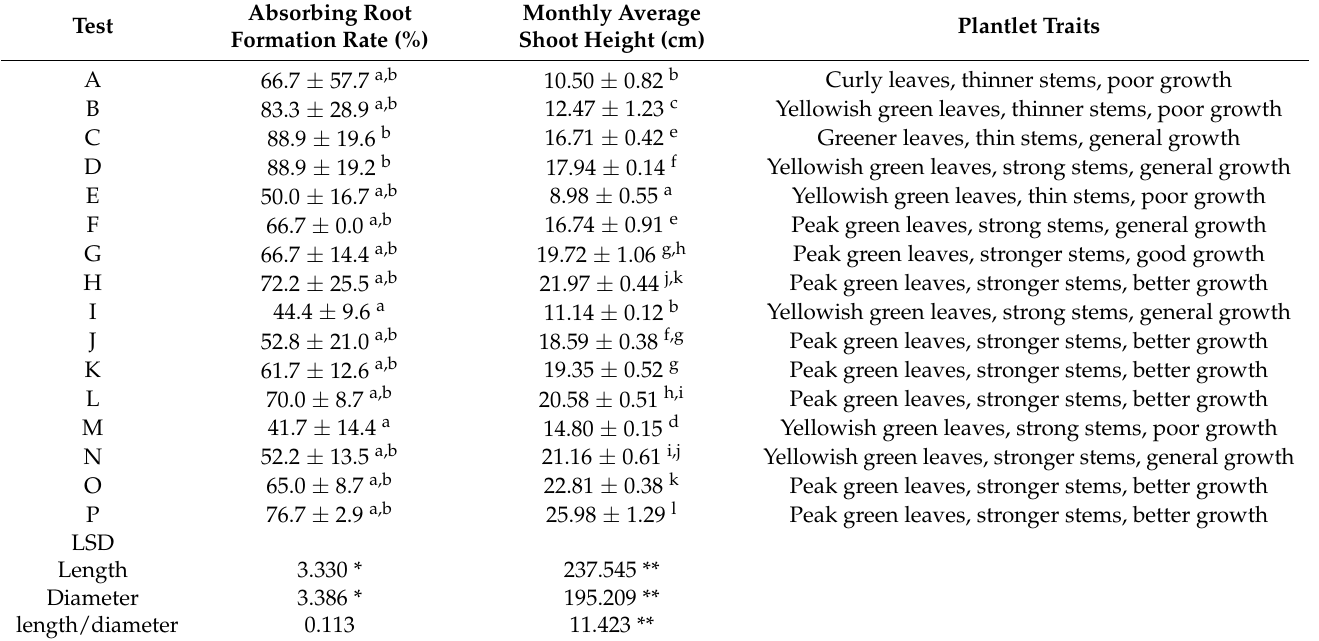
Table 4. Effects of different root sizes on absorbing root formation rate and average monthly plantlets height of Broussonetia papyrifera